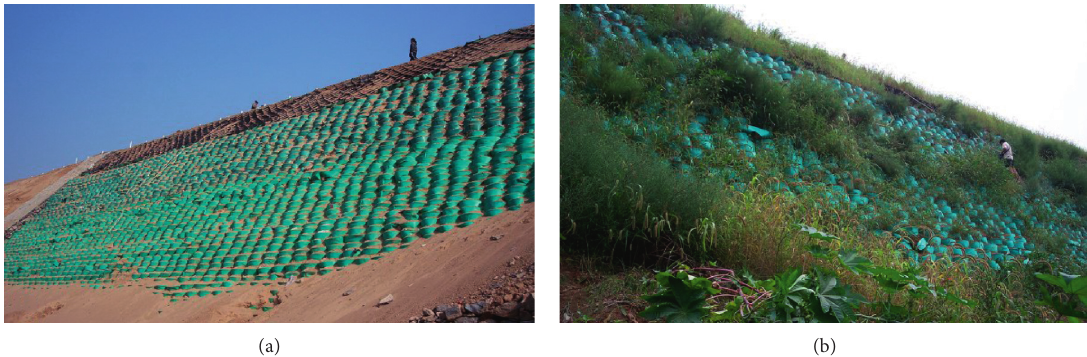
Figure 13: Application effect of flexible ecological retaining wall for slope protection. (a) After construction completion. (b) One year after